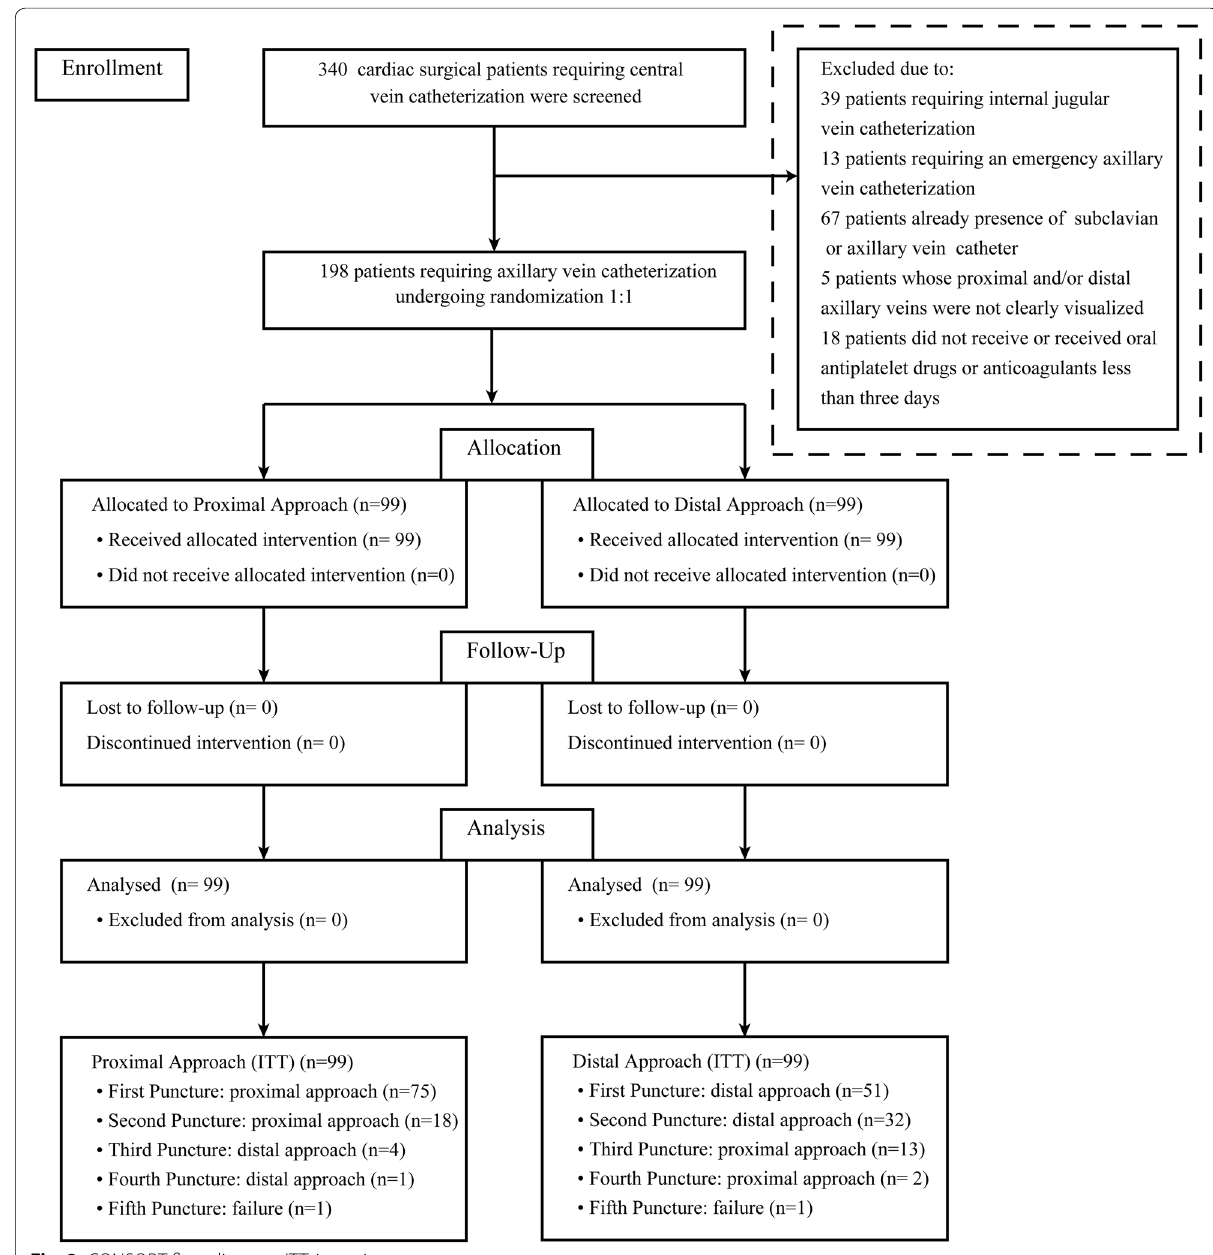
Fig. 2 CONSORT flow diagram. ITT,